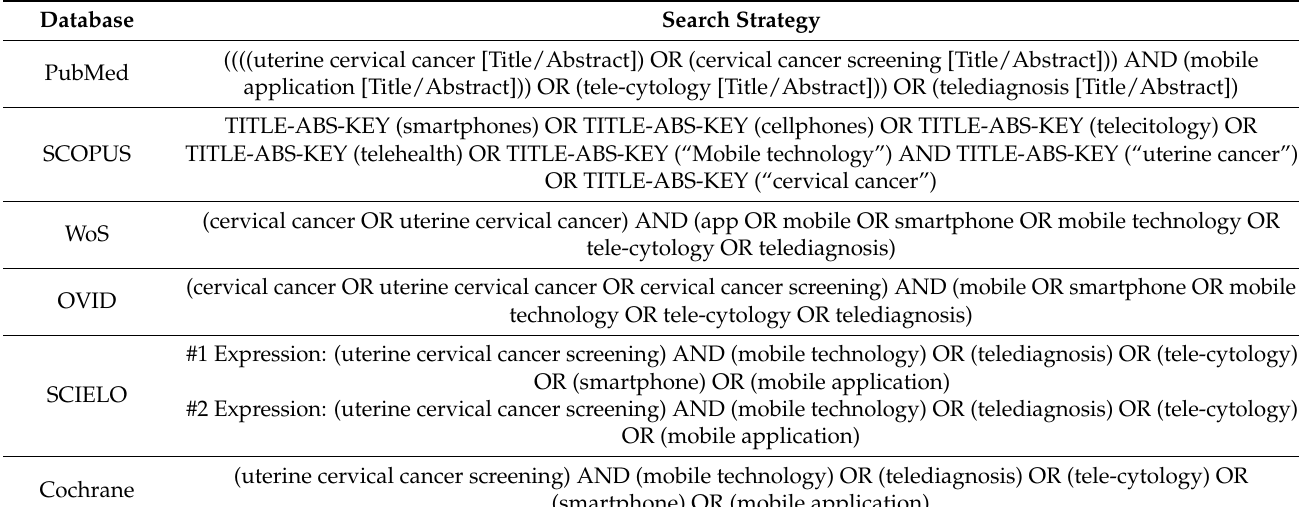
Table 1. Search strategy of papers in